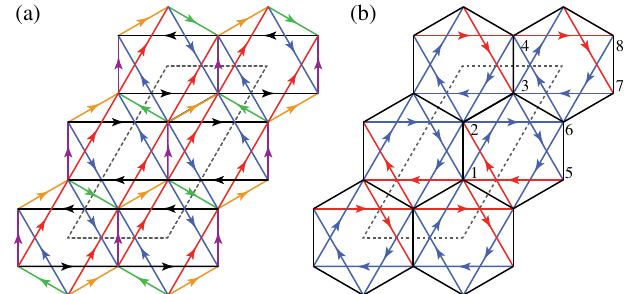
FIG. 4. The real space pattern of the slave-fermion amplitudes describing the CSDW or SCCL phases. The dashed line encircles the doubled unit cell. (a) The nearest-neighbor (NN) and next- nearest-neighbor (NNN) boson pairing amplitudes A are direc- ij − A tional (labeled by arrows) since A . A on the NN ij ¼ ji ij (NNN) bonds have the same magnitude, respectively. Their different phases are represented by different colors. Black, 1; violet, e i π = 2 ; green, e i 5 π = 6 ; orange, e i π = 6 ; red, e i π = 3 ; blue, e i 2 π = 3 . = χ (b) The NN (NNN) boson/fermion hopping amplitudes B ij ij also have uniform magnitudes, respectively. When they are χ (cid:2) B (cid:2) complex, the amplitudes are directional B , χ ij ¼ ij ¼ ji ji (labeled by arrows). The phases are illustrated by colors. Black, (cid:3) 1 ; blue, e i ϕ ; red, − e i ϕ . Here, the real number ϕ ¼ ϕ b for bosons and ϕ ¼ ϕ for fermions. ϕ and ϕ can be viewed as two f b f variational parameters. The above pattern is for one of the two degenerate ground states while the other one is its time-reversal image, which can be obtained by sending these amplitudes to → A (cid:2) =B = χ =B (cid:2) = χ (cid:2) their complex conjugates: A . Sites num- ij ij ij ij ij ij bered 1 to 8 label the quadrupled unit cell used in Appendix